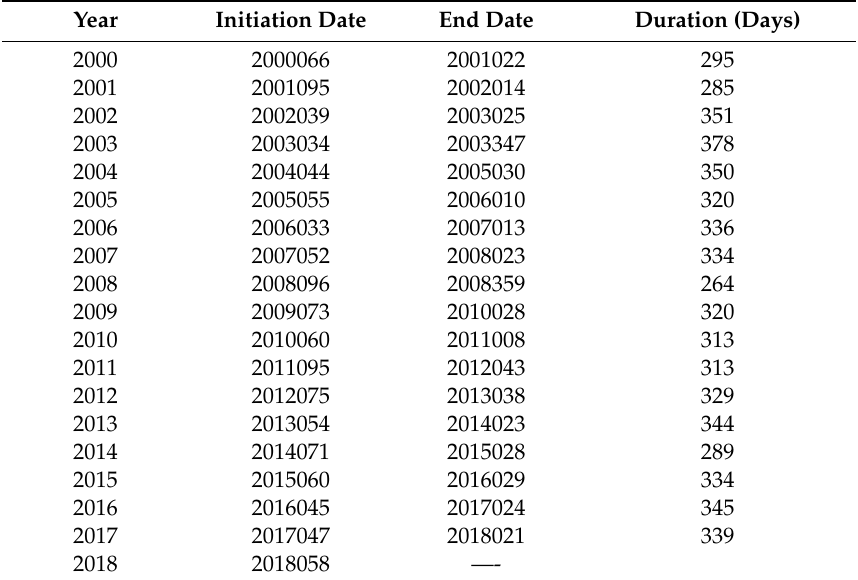
Table 3. Algal bloom initiation and duration of Lake Dianchi from 2000 to 2018 in MODIS images.